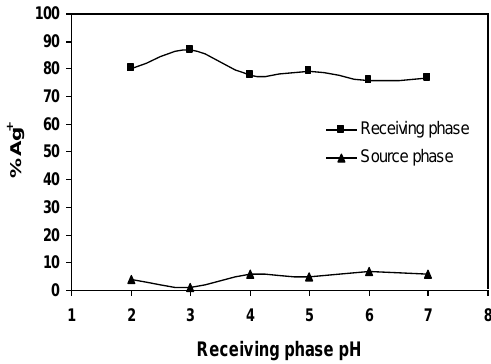
Figure 5. Effect of pH in receiving phase on Ag + cation transport. Experimental conditions: source phase, 10 ml of 3.0×10 -4 M Ag + cation and 3.0×10 -3 M picric acid at pH 4; liquid membrane phase, 50 ml of 1.0×10 -3 M carrier in DCM; receiving phase, 5 ml of 1.0×10 -3 M S O 32- with various pH; time of transport, 4 2